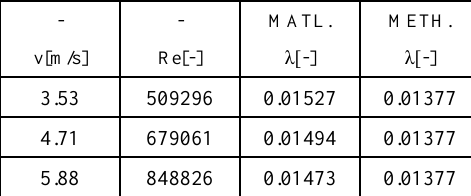
Fig. Pipeline characteristics for 3xDN150 - 700, 1000, 1500, 2200 m (solid line – Methodology, dashed line – MATLAB)